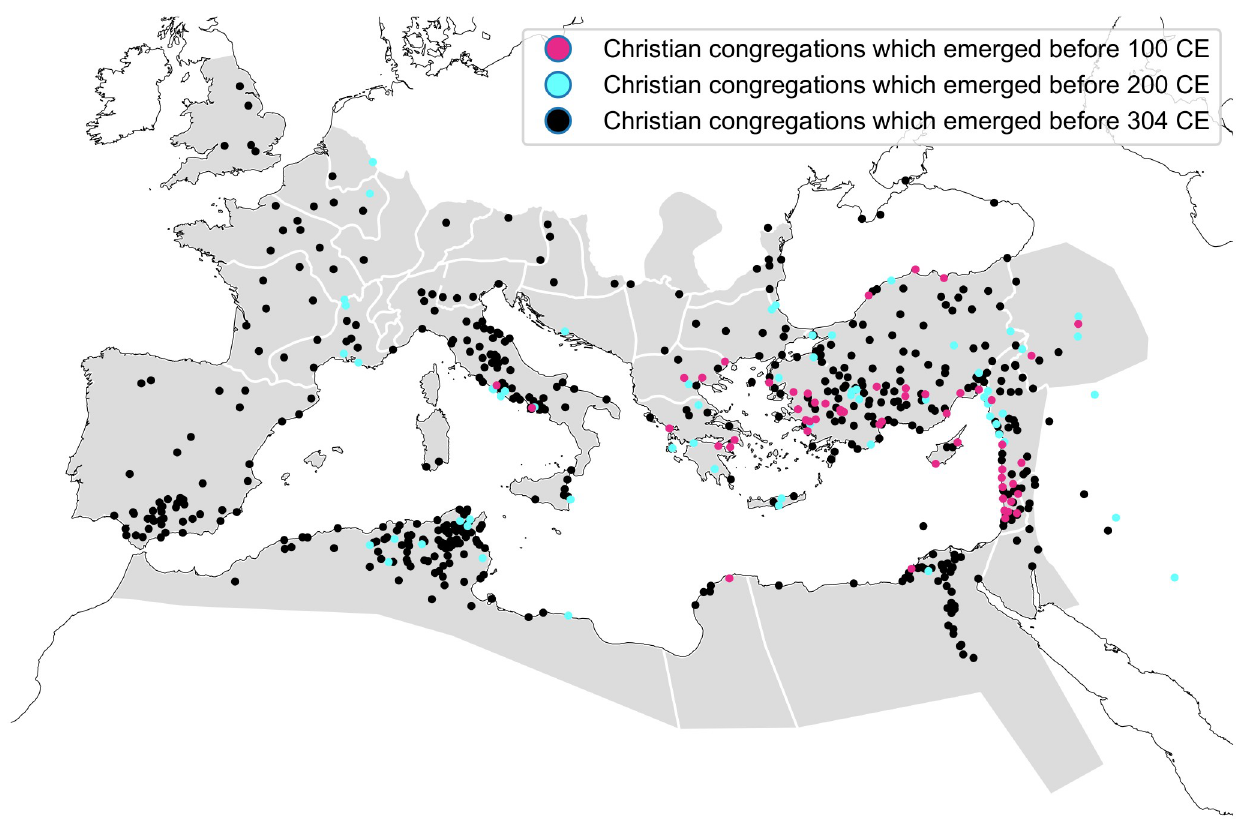
Fig 1. The spatio-temporal distribution of the documented presence of Christian congregations. The congregations from the three periods of interest [20] are shown on the outline of Roman provinces [21]. The map includes also congregations outside the empire.